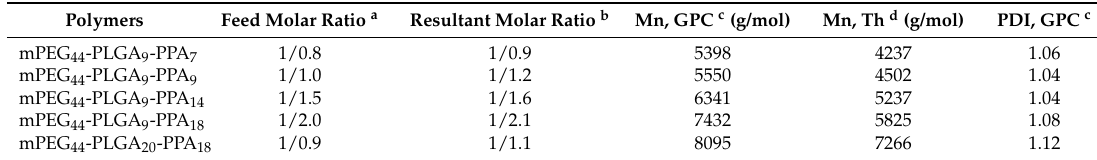
Table 1. Molecular weight of mPEG-PLGA-PPA copolymers.